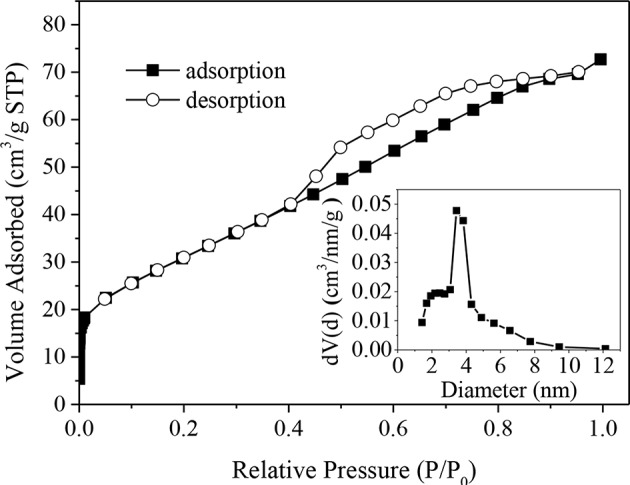
N2 adsorption-desorption isotherm and pore size distribution of CuO/CeO2.